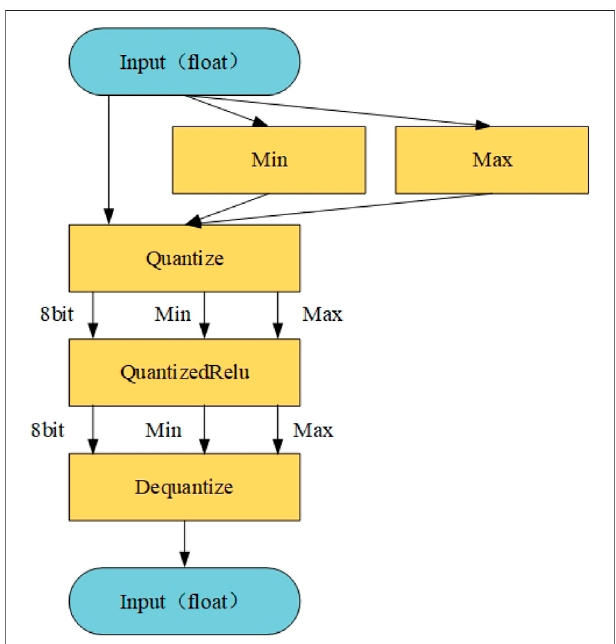
FIGURE 7 | Relu operation after quantization.